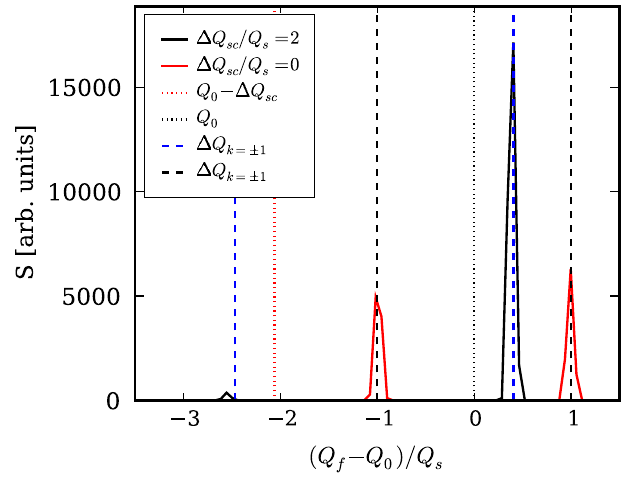
FIG. 3. (Color) Spectrum of the dipole mode (cid:3) x 1 obtained from the PATRIC code for an airbag distribution. The red curve corre- sponds to (cid:1) Q sc =Q s ¼ 0 , the black curve to (cid:1) Q sc =Q s ¼ 2 . The ¼ (cid:1) Q = 4 . dashed blue lines represent (cid:1) Q (cid:3) 1 for (cid:1) Q sc =Q s ¼ 2 . The dashed coh sc black lines are at (cid:3) Q s . The dotted red line is the tune shifted by space